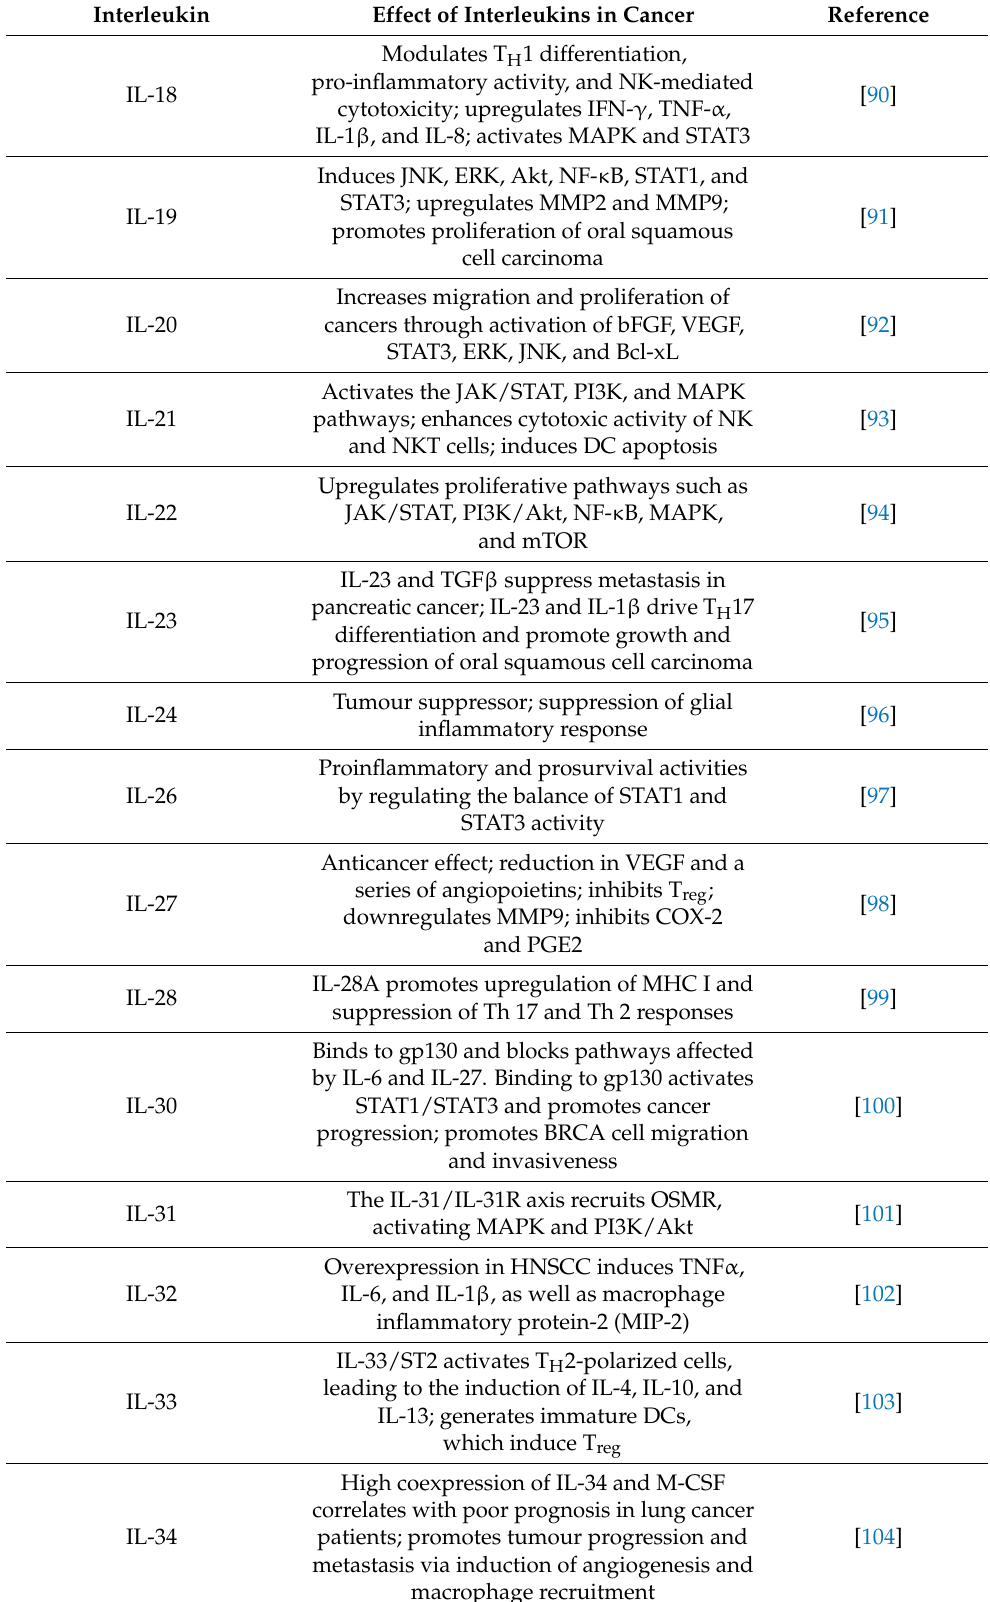
Table 2. Cont. Interleukin Effect of Interleukins in Cancer